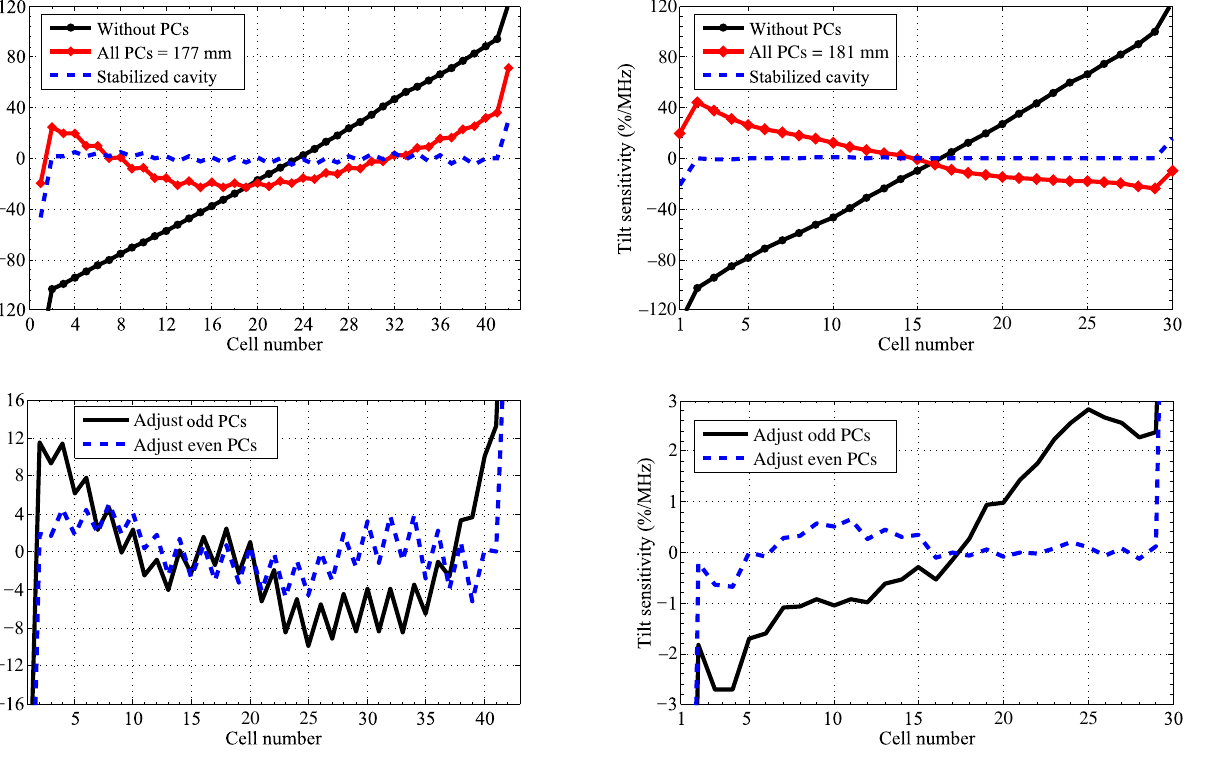
FIG. 11. Results of the post-coupler optimization for Linac4 Tank 2. The initial tilt sensitivity is reduced by a factor of 20. The jagged pattern is repeated in tilt sensitivity due to having only one post-coupler every two drift tubes. The lower graph is zoomed in tilt sensitivity.